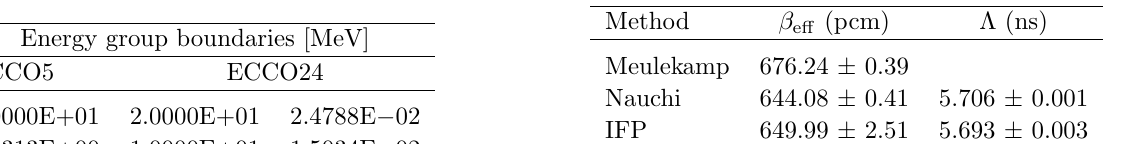
Table 12. Energy grids used for group constant generation.